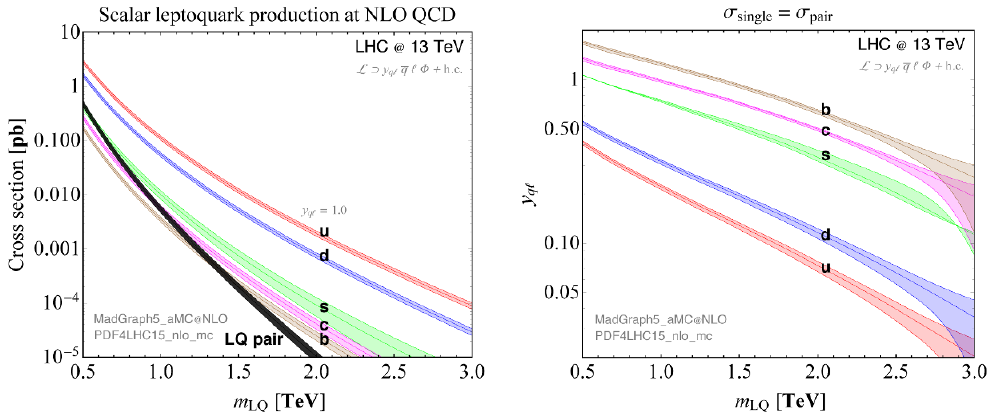
Figure 2 . (Left panel) Total inclusive cross sections (in pb) at NLO in QCD for scalar LQ production in proton-proton collisions using the PDF4LHC15 nlo mc [29] sets at 13 TeV center-of- mass energy as a function of the LQ mass m LQ . The central values are obtained using (cid:12)xed factorisation and renormalisation scales (cid:22) F = (cid:22) R = m LQ . The total uncertainty (shown with bands) is obtained by adding the PDF and perturbative uncertainties in quadrature, where the former one is given by the 68% C.L. ranges when averaging over the PDF replicas while the latter one is estimated varying factorisation and renormalisation scales within (cid:22) F ; (cid:22) R 2 [0 : 5 ; 2] m LQ . Prediction for the single LQ production ( pp ! (cid:8) ‘ plus pp ! (cid:22)(cid:8)(cid:22) ‘ ) initiated from up, down, strange, charm, and bottom initial-state (cid:13)avours is marked with u , d , s , c , and b , respectively, while the LQ pair production ( pp ! (cid:8)(cid:22)(cid:8)) is denoted with LQ pair . All single LQ production cross sections correspond to the case when the coupling strength of the LQ to the quark-lepton pair is set to p one ( y q‘ = 1). (Right panel) y q‘ = (cid:27) pair =(cid:27) single ( y q‘ = 1) as a function of the LQ mass for all initial-state quarks at 13 TeV. The three lines for each quark (cid:13)avour are obtained using central, plus, and minus predictions for the total cross sections, and the shaded area indicates the size